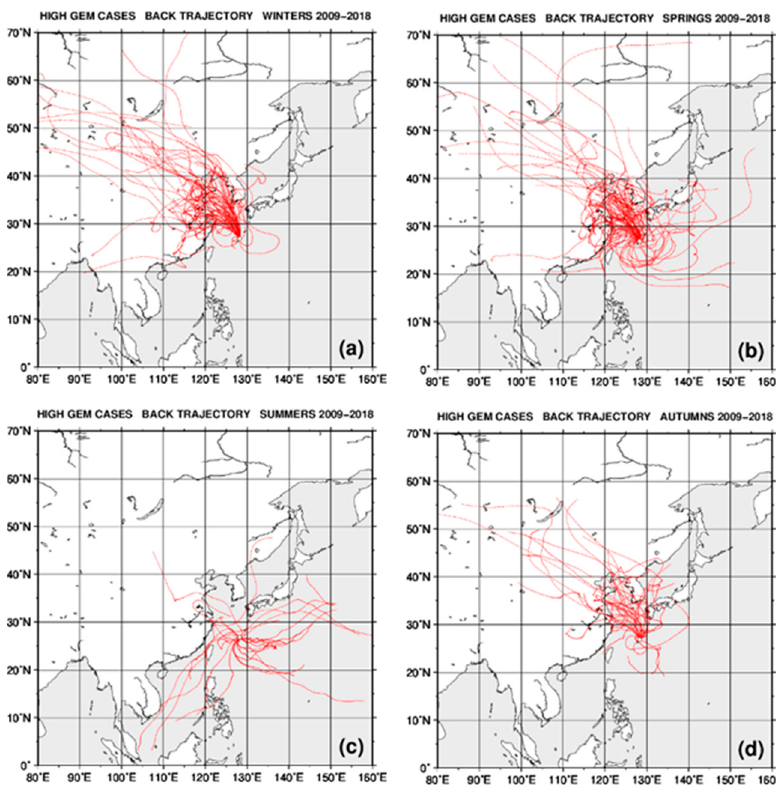
Figure 5. Seasonal changes in the pathway of the air mass arriving at Cape Hedo when GEM pollution events were observed in ( a ) winter, ( b ) spring, ( c ) summer, and ( d ) fall. Atmosphere 2019 , 10 , x FOR PEER REVIEW